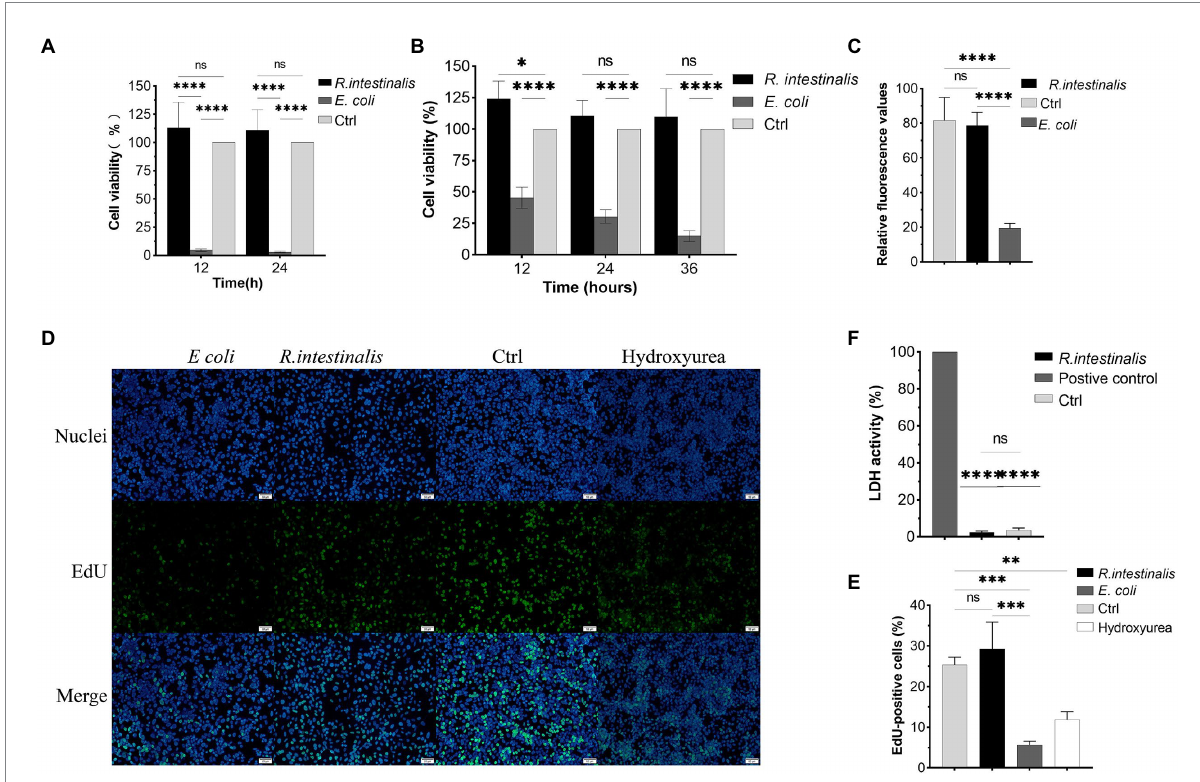
FIGURE 5 Cytotoxic effects of R. intestinalis . (A,B) Cytotoxic effects of R. intestinalis on HT-29 and NCM460 cells after 12–36 h of treatment. (C) Calcein-PI staining in live and dead cell detection test. (D,E) EdU cellular proliferation test. The hydroxyurea treatment group served as the positive control. (F) LDH activity test. * indicates p < 0.05, ns indicates no